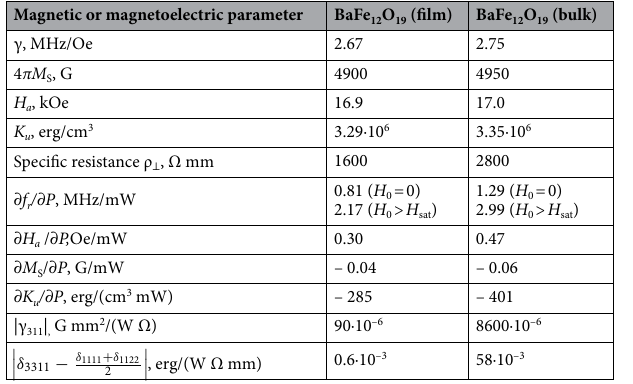
Table 1. Magnetic and magnetoelectric parameters of single crystal thick film and LPE thin film of M-type barium